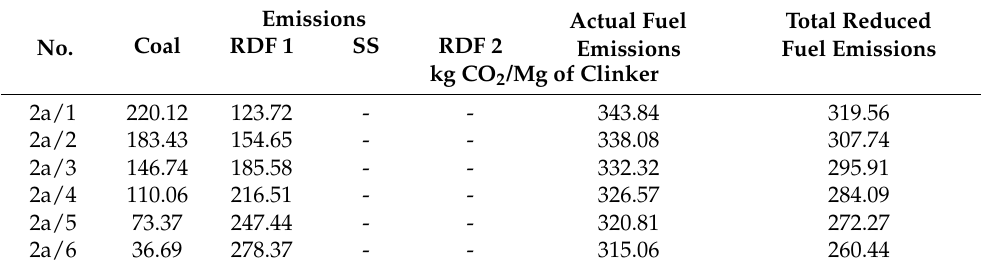
Table 5. The CO 2 emissions balance of blends of coal with RDF 1 (2a—two components).